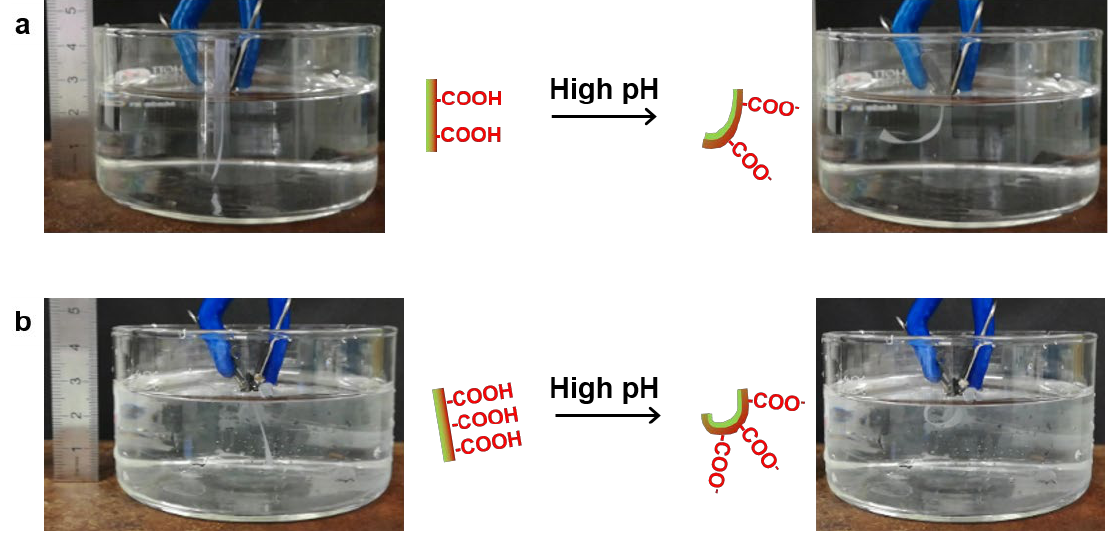
Figure 2. Photographs showing the bending of ( a ) NFC/TOCN5 and ( b ) NFC/TOCN9 nanopapers when they were immersed in high pH aqueous solutions (pH 13).